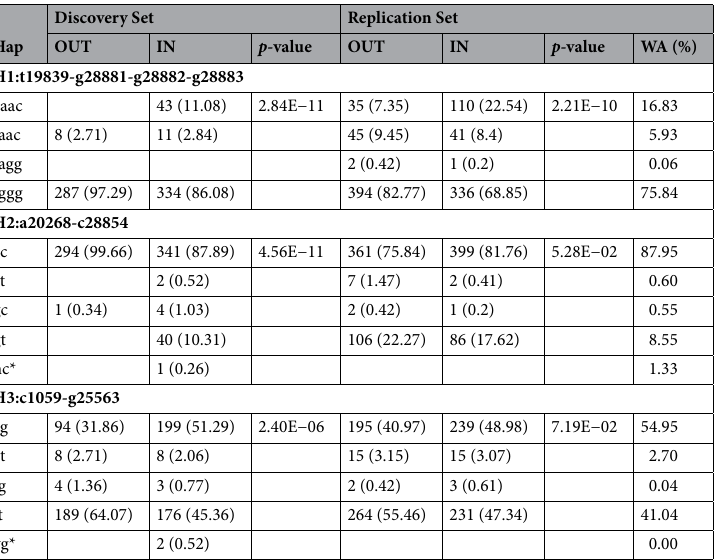
Table 3. Association results of three SNV-haplotypes with hospitalization status (inpatient and outpatient) in a case–control study of 683 COVID-19 patients: frequencies of haplotypes among outpatients and inaptients, estimated coefficients, and Fisher’s exact p -values, respectively, across three haplotypes. Also included are haplotype frequencies in general population of Washington state (far right column). *n—untyped nucleotide, y—ambiguity typing of either c or